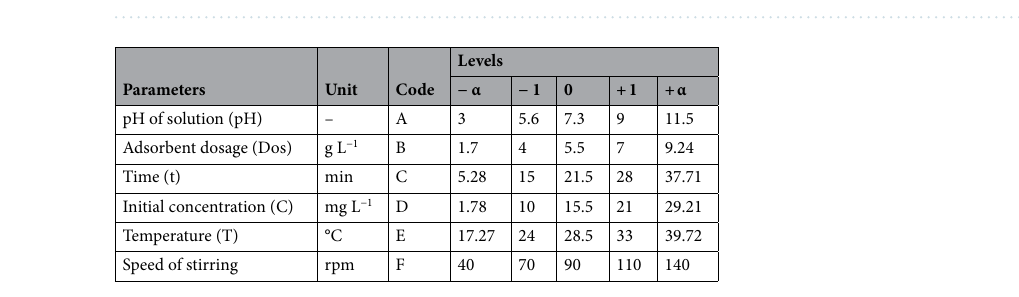
Figure 5. FE-SEM images of Fe 3 O 4 @MOF-PAMAM before ( a ) and after ( b , c ) adsorption of MB; EDX analysis of Fe